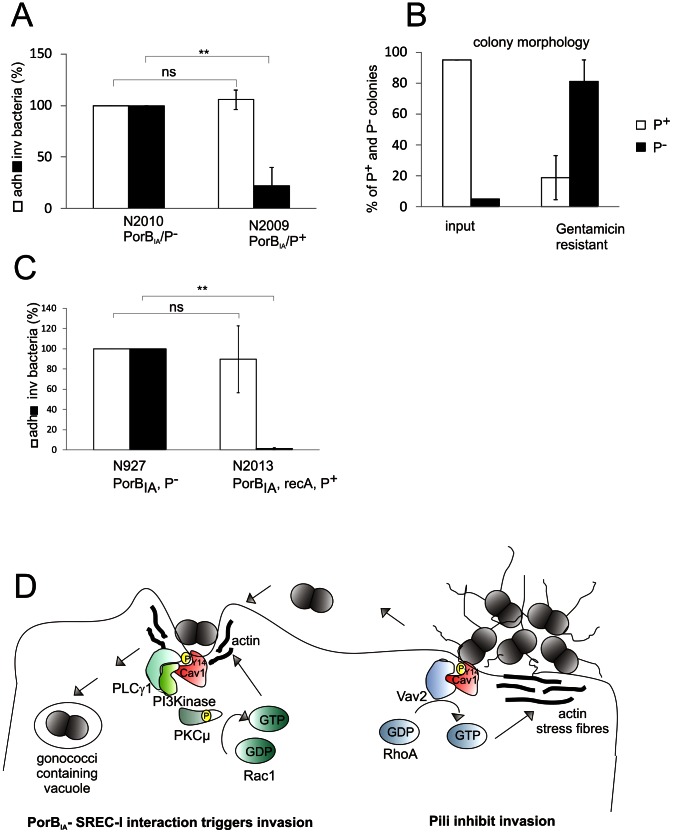
Pili interfere with PorBIA-dependent invasion.(A) Chang cells were infected with N2009 (PorBIA, P+) or N2010 (PorBIA, P−) at MOI 10 for 1 h and then analyzed by gentamicin protection assays. The number of adherent (white bars) and invasive (black bars) bacteria of the strain N2010 was taken as 100%. The graph shows mean values ± SD of two independent experiments performed in duplicates. (B) Intracellular N2009 are highly enriched for non-piliated variants. Piliated (white bars, Pili+) and non-piliated (black bars, Pili−) gentamicin resistant N2009 gonococci recovered from the experiment shown in (A) were quantified for their pilus phenotype with a steromicroscope. (C) Chang cells were infected at an MOI of 10 for 30 min with N927 (PorBIA, P−) or with N2013 (recA
i, PorBIA, P+), a recA mutant which cannot undergo pilE recombination. The bar chart shows the results of a gentamicin protection assay as the mean values ± SD of three independent experiments done in duplicates. The number of adherent (white bars) and invasive (black bars) bacteria of N927 was set to 100%. p<0.01: ** (D) Model of the molecular events underlying the switch from local to invasive gonococcal infection.